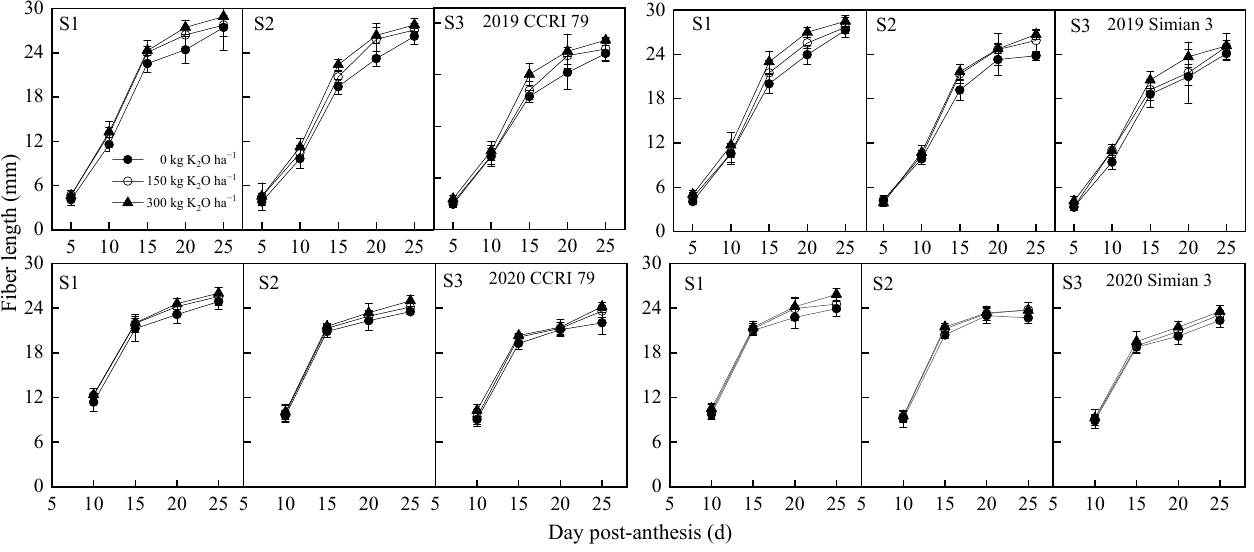
Figure 1. Effect of K application on dynamic changes in cotton fiber length from 5 to 25 DPA under salt stress. S1, low salinity; S2, moderate salinity; S3, high salinity.